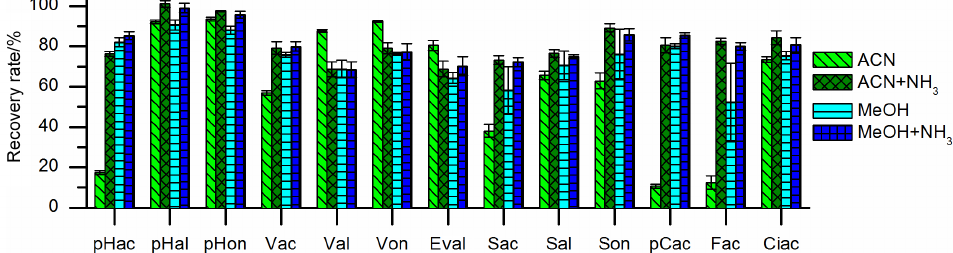
Figure 3. Recovery rates of the 13 LOPs on oasis HLB SPE cartridges eluted with acetonitrile (ACN), acetonitrile with ammonia (ACN + NH 3 ), methanol (MeOH), and methanol with ammonia (MeOH + NH 3 ). The recovery rates improved significantly if ammonia was added to the elution solvent.